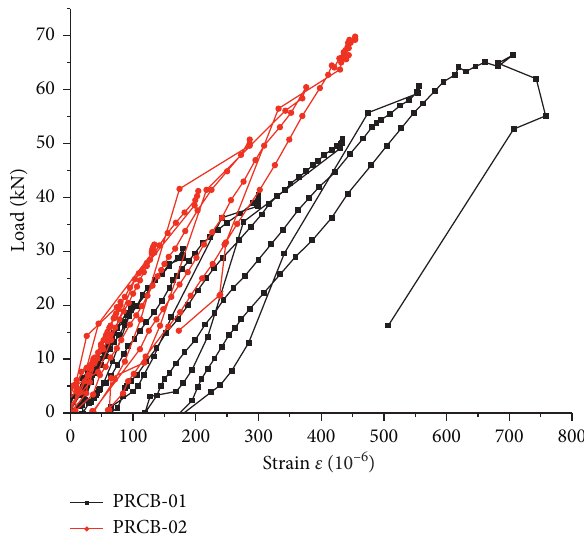
Figure 12: Strain curve of bolts at position